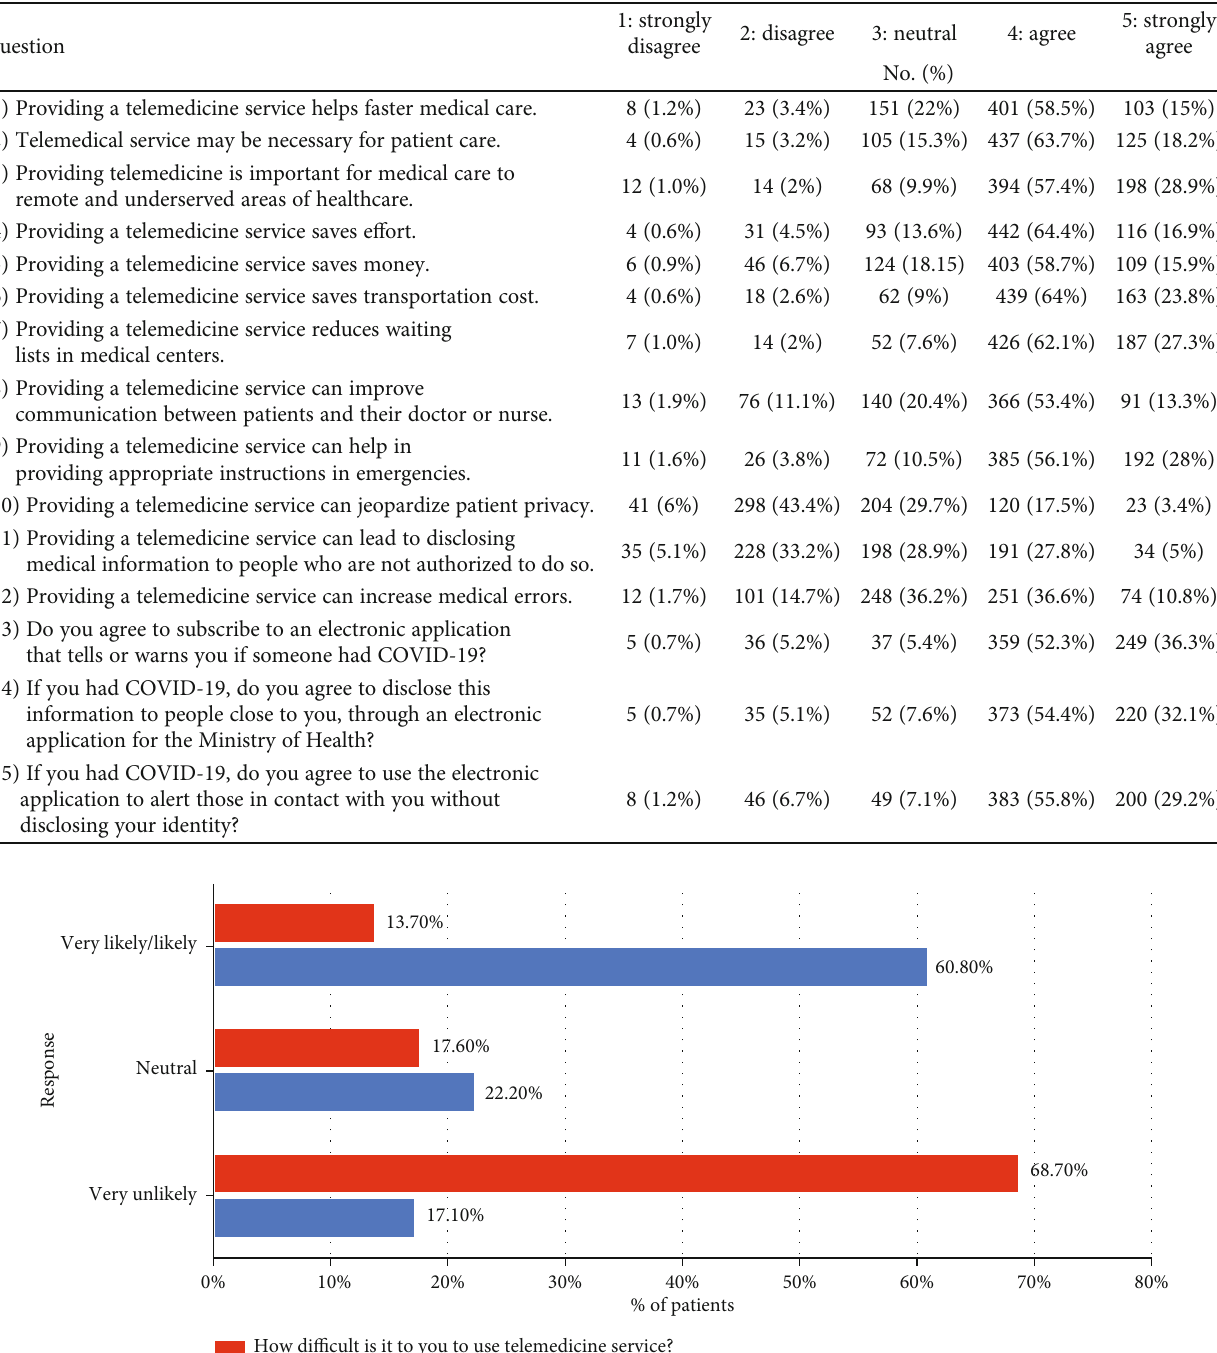
Table 2: Description of knowledge and attitude toward telemedicine among participants ( n = 686 ). Question